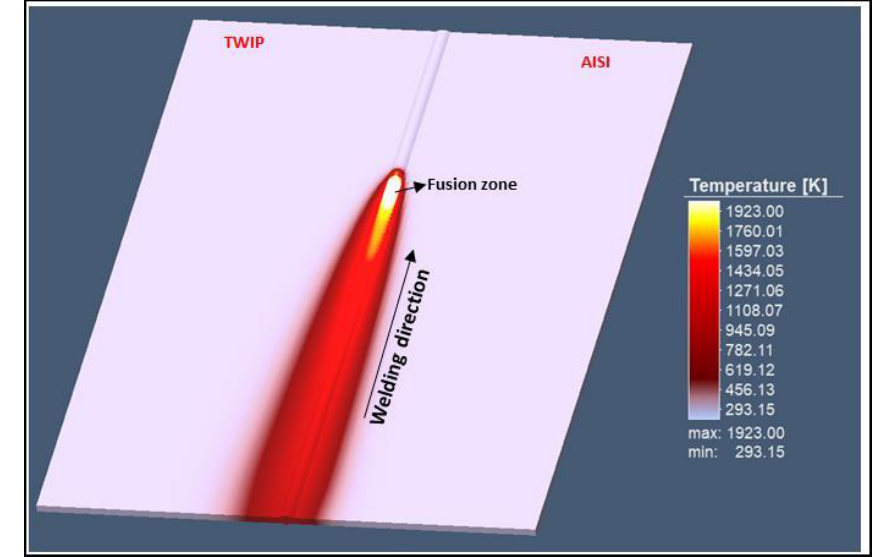
Figure 6. Temperature field during welding.